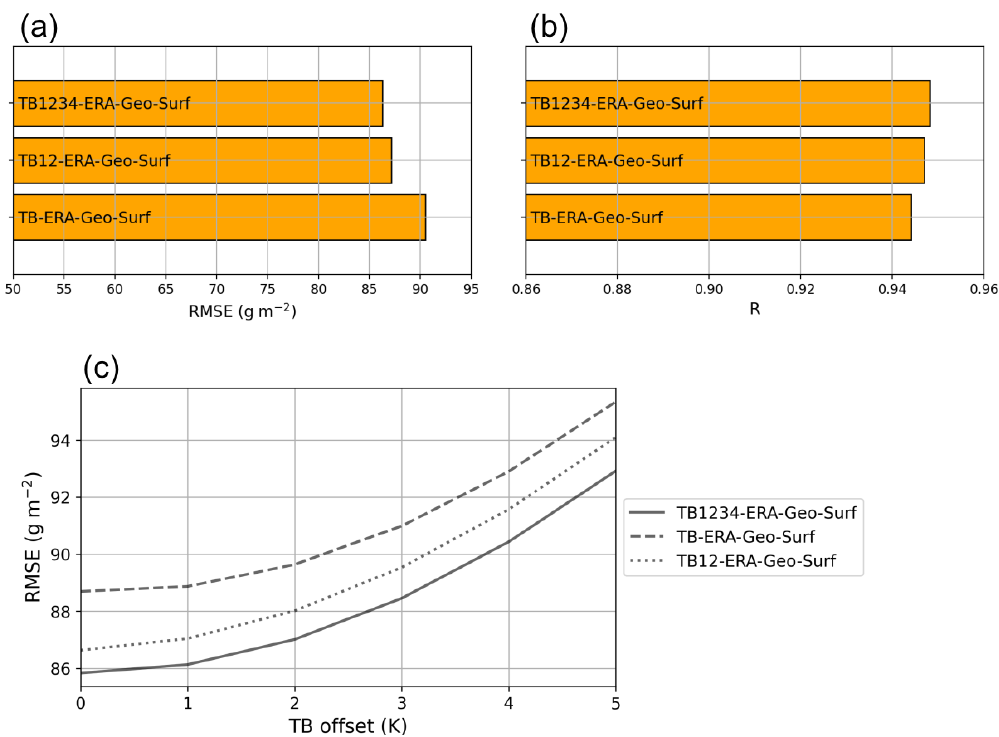
Figure A2. Effect of higher-order T B polynomials on LWP retrieval. Panels (a) and (b) show the RMSE and R for the testing set. It comes across that the best results are obtained with the full set of T B polynomials up to the fourth order. Using only T B and T 2 results, with slightly higher RMSE. Panel (c) illustrates how the RMSE changes when a constant T B offset is added to the testing input, simulating a miscalibration of the radiometer. In terms of relative increase, the retrieval with T B only is slightly less affected, but the RMSE remains higher than that of the other